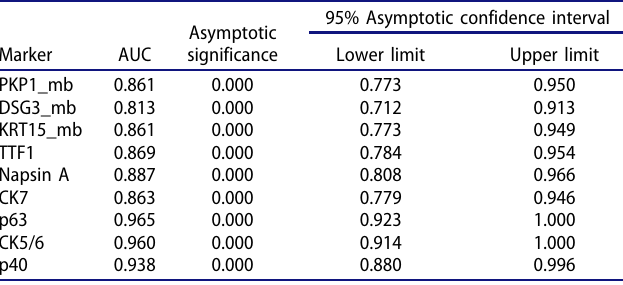
AUC: area under the